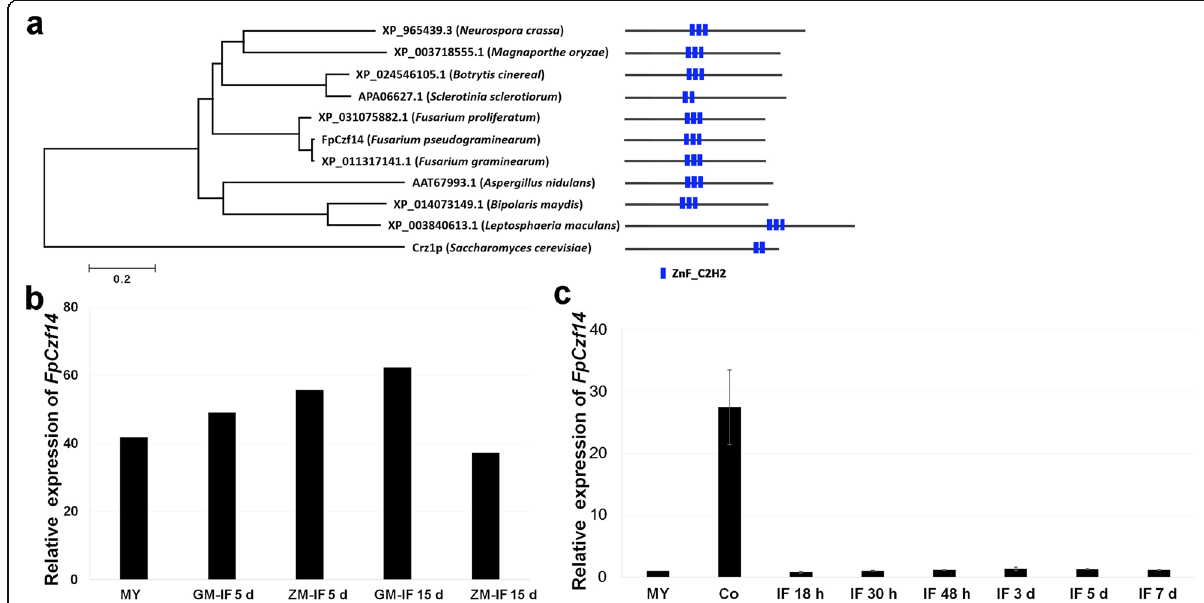
Fig. 1 Identification and characterization of FpCzf14 in F. pseudograminearum . a Phylogenetic analysis and CZF domain identification of FpCzf14 homologues in several organisms. b Transcriptional levels of FpCzf14 in mycelia and at the infection stage of F. pseudograminearum . Raw transcriptome data were previously submitted to the NCBI database (Submission ID: SUB5545839) (Chen et al. 2019). My, mycelia; GM-IF 5 d and GM-IF 15 d indicate samples from susceptible wheat cultivar Guomai301 at 5 and 15days post-inoculation (dpi) with F. pseudograminearum , respectively; ZM-IF 5 d and ZM-IF 15 d indicate samples from resistant wheat cultivar Zhoumai24 at 5 and 15 dpi with F. pseudograminearum , respectively. dpi. c Transcription profile of FpCzf14 in mycelia, conidia, and infected wheat coleoptiles from 18h post-inoculation (hpi) to 7 dpi analyzed by RT-qPCR. My, mycelia; Co, conidia; IF 18h, 30h, 48h, 3 d, 5 d, and 7 d indicate samples from susceptible wheat cultivar Aikang58 at 18 hpi, 30 hpi, 48 hpi, 3 dpi, 5 dpi, and 7 dpi,